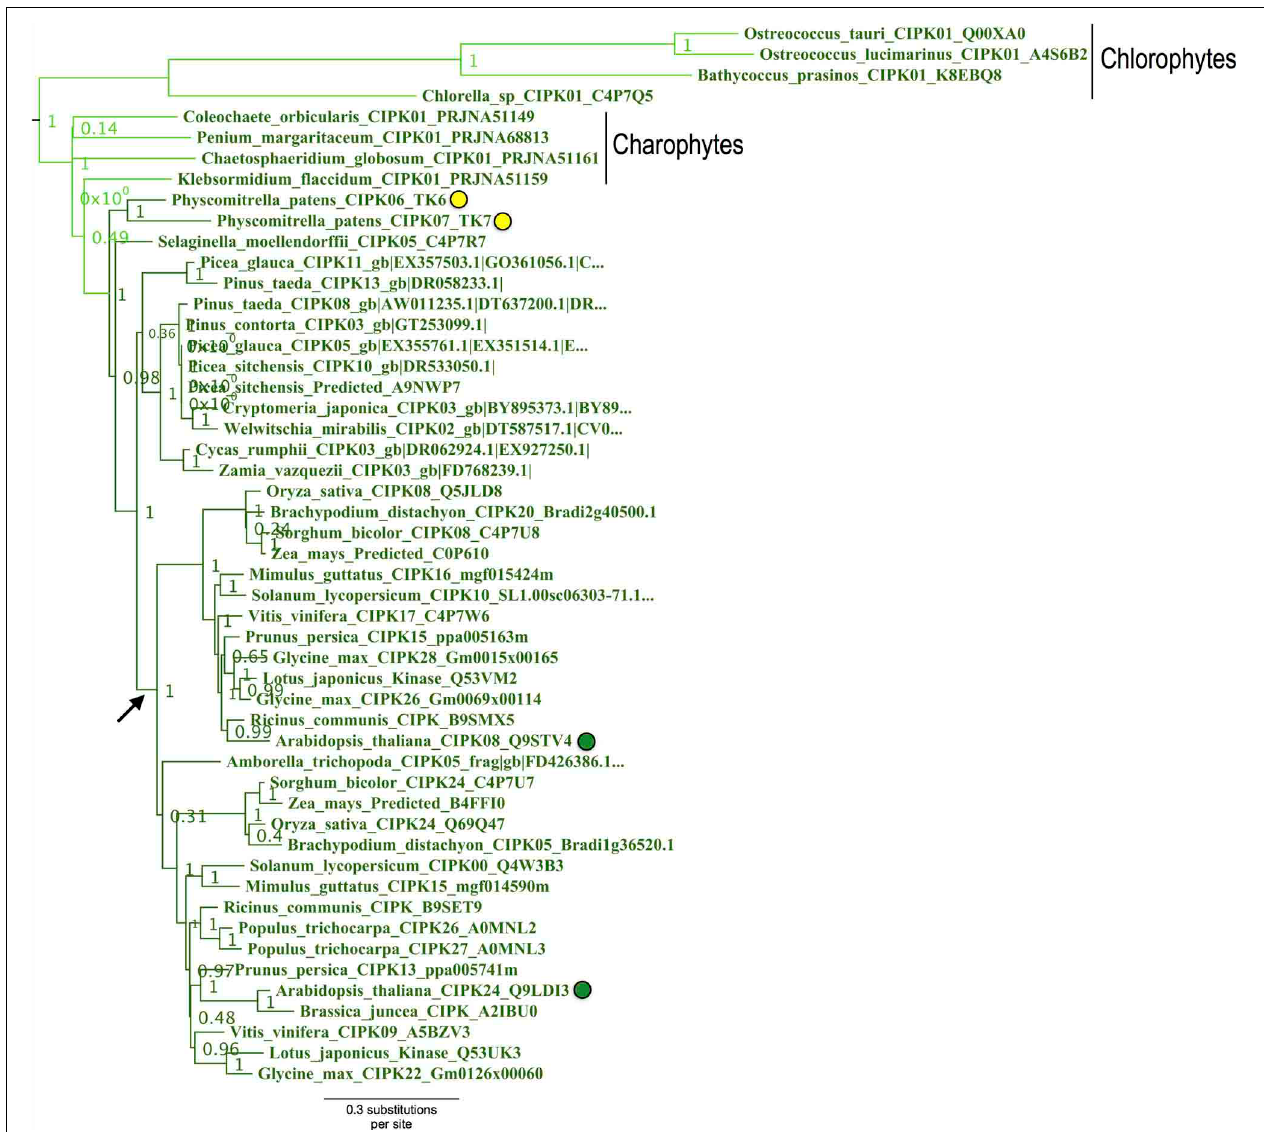
FIGURE 9 | Close-up of the “green algal-type” CIPK clade from ML tree shown in Figure 8. Confidence scores (aLRT) are shown for each clade. Phylogenetic evidence strongly supports the existence of a clade (aLRT = 1.0) containing all CIPK homologs identified from chlorophyte and charophyte green algae, as well as two CIPKs each from Physcomitrella